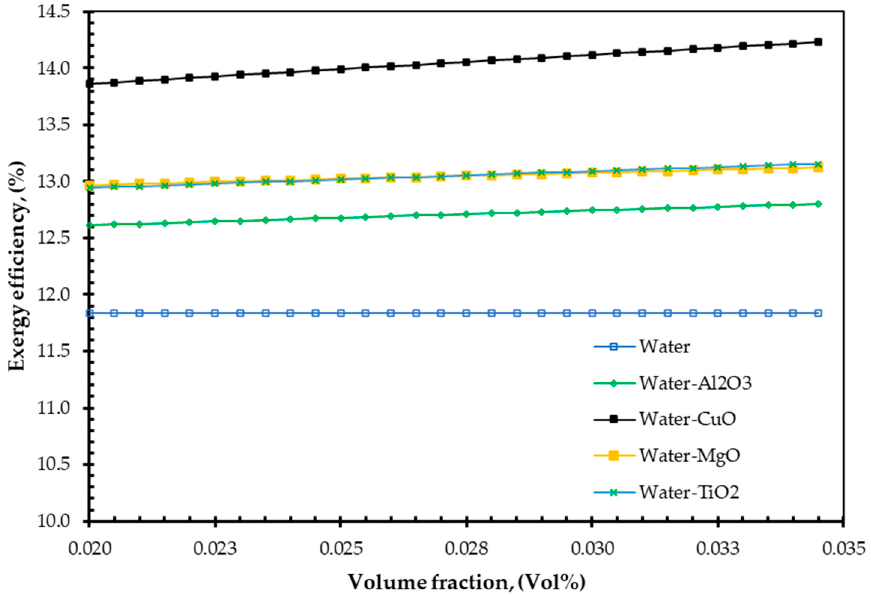
Figure 7. Effect of particle volume fraction on exergy efficiency.